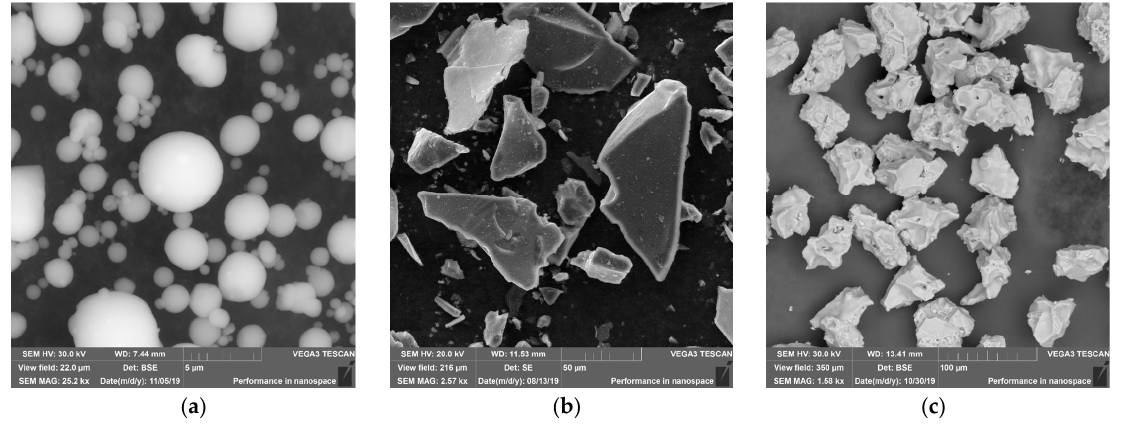
Figure 3. Aluminum ( a ), boron ( b ) and titanium carbide powders ( c ). The residual stresses in the fabricated composites were measured by an X-ray di ff rac- tion analysis. The X-ray pa tt erns were obtained on a DRON-3 X-ray di ff ractometer (Rus- sia) using fi ltered copper radiation. Exposure to the X-ray was carried out in the range of angles 110–120° at a step of 0.05°, with the exposure at each point providing a statistical